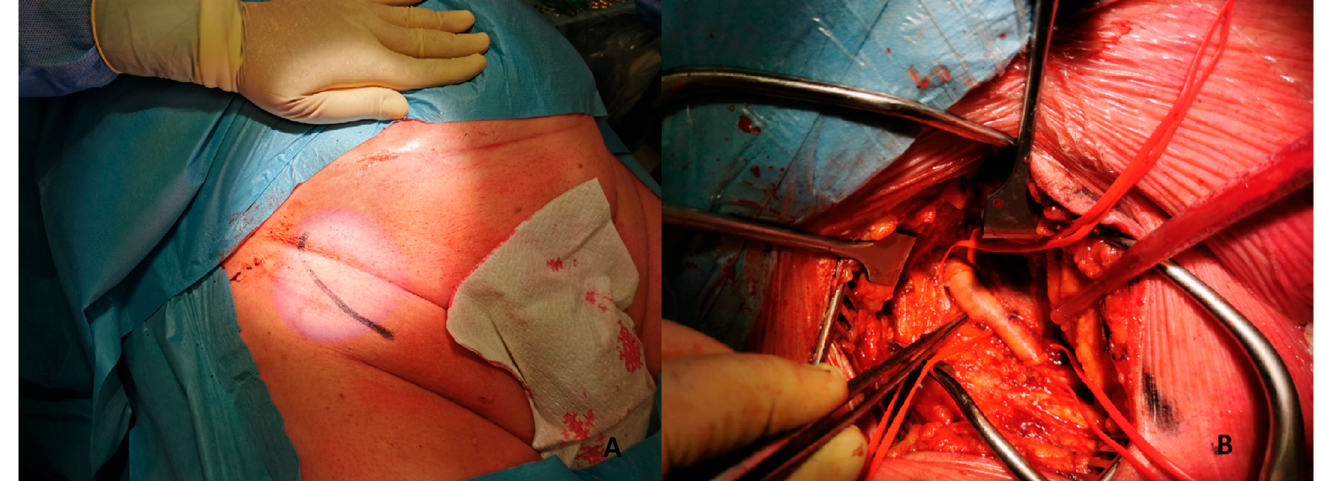
Figure 5. ( A ). Skin incision on the groin. ( B ). Exposure of common femoral artery.